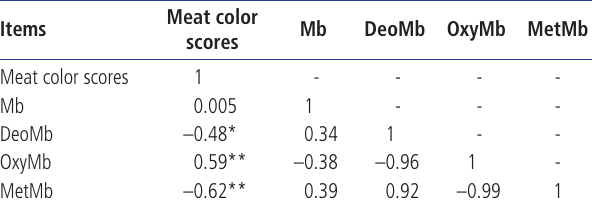
Mb, total myoglobin; DeoMb, deoxymyoglobin; OxyMb, oxymyoglobin; MetMb, metmyo- globin. n = 18. Pearson coefficients, * p<0.05, **